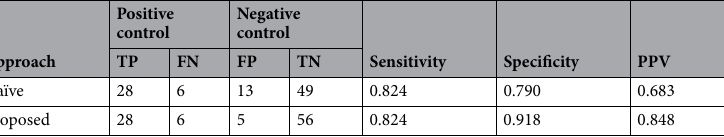
Table 1. Results of differential site occupancy analysis at the FDR cutoff 0.05 in comparisons for positive and negative controls. The hypothesis testing is based on the null hypothesis H 0(1) as in Fig. 3c. The comparison between AI 3 mM AAPH or AI 10 mM AAPH versus AI reference samples for sites in Fab and Fc is considered as positive control, where all forms are expected to change. The comparison between ADC reference and AI reference samples excluding the sites for the linker-drug modifications is considered as negative control, where none of the forms is expected to change. Performances of the naïve approach and the proposed approach are compared based on sensitivity, specificity, and positive predictive value (PPV). Sensitivity is calculated as TP/(TP + FN), where TP is the number of true positives and FN is the number of false negatives. Specificity is calculated as TN/(FP + TN), where FP is the number of false positives and TN is the number of true negatives. PPV is calculated as TP/(TP +